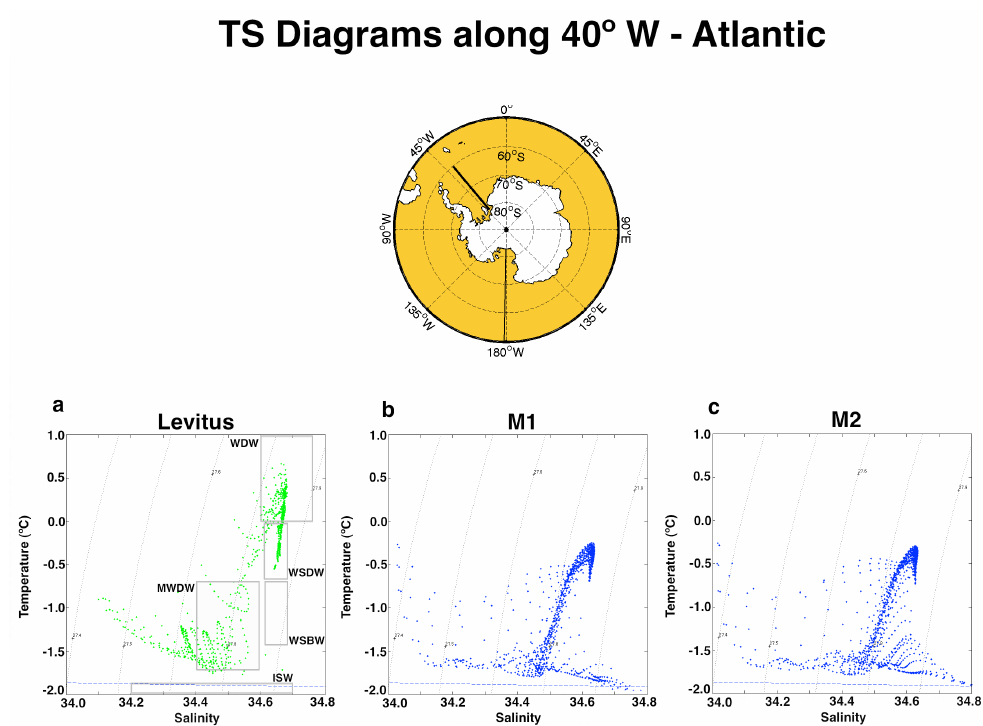
Fig. 9. T – S diagrams for the Weddell Sea along 40 ◦ W for the annual mean values of Levitus (a) , M1 (b) and M2 (c) simulation results. The boxes inside the upper left panel indicate the thermohaline limits for the typical water masses reported in the Weddell Sea.